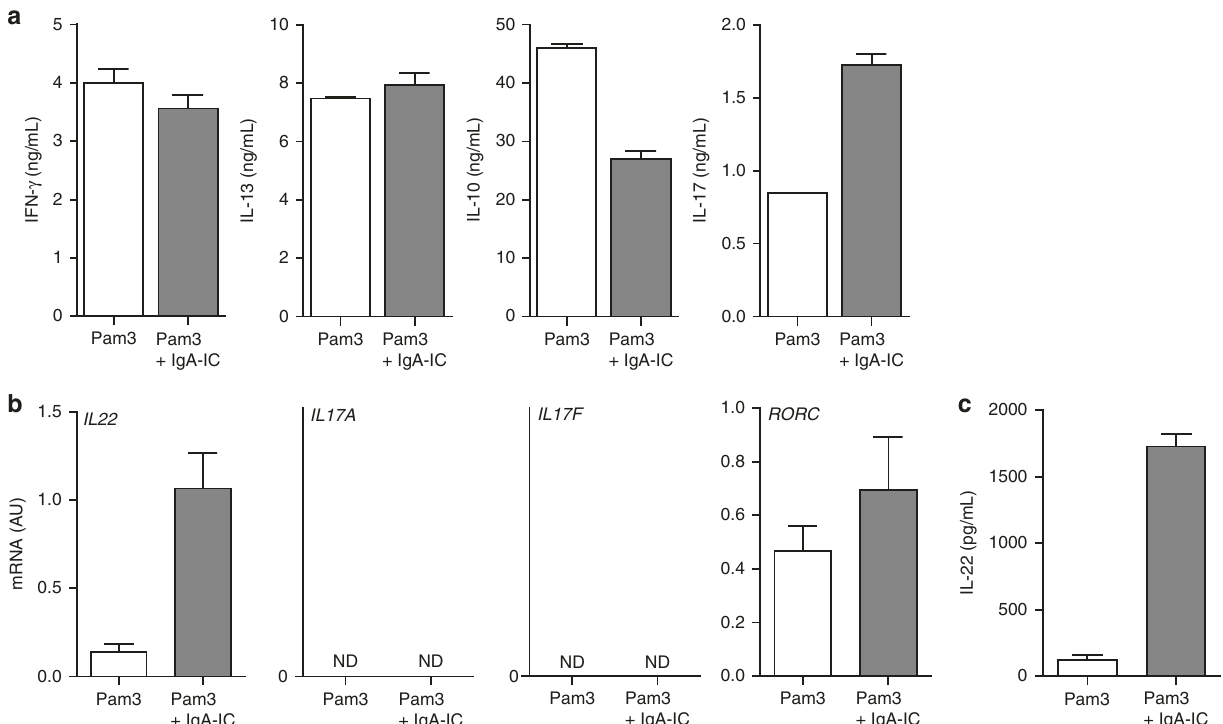
Fig. 4 Co-stimulation of CD103 + DCs with IgA-IC promotes Th17 responses and activates intestinal ILC3. a CD103 + dendritic cells (DC) were stimulated with Pam3CSK4 (Pam3) alone or Pam3CSK4 together with IgA immune complexes (IgA-IC) and co-cultured with CD4 + T Cells. After T-cell outgrowth, resting cells were re-stimulated and after 24 h supernatant was assayed with ELISA, mean + s.e.m. Experiments were performed in triplicate. b , c Supernatant from CD103 + DCs which were stimulated with Pam3CSK4 or Pam3CSK4 with IgA-IC was transferred onto human intestinal ILC3 and cultured for 7 days and analysed for mRNA expression ( b ) or protein expression ( c ). ND, not detected. Experiments were performed in triplicate. mRNA expression of indicated genes were assayed using qPCR (normalized to GAPDH expression) mean + s.e.m. Supernatant was analysed using ELISA, mean + s.e.m. Representative example of three ( a , b ) or two ( c ) experiments using different